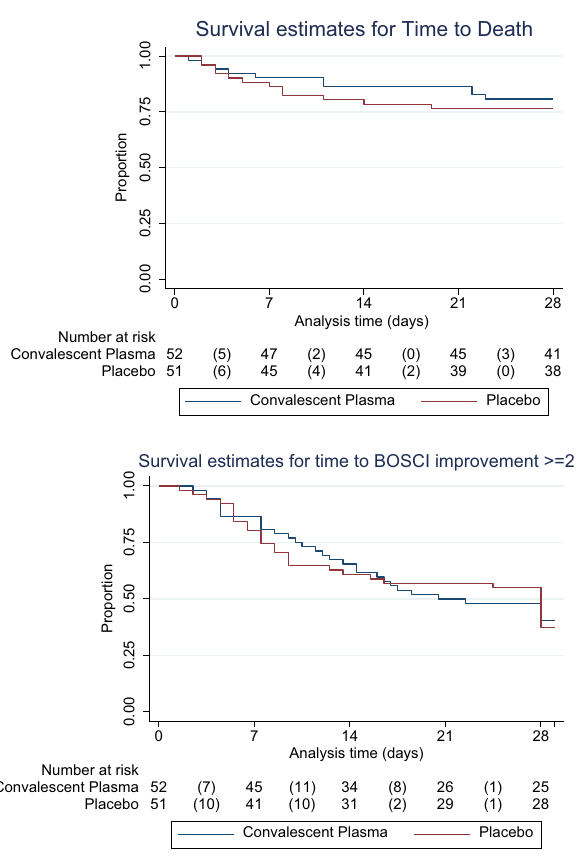
Figure 3. Kaplan–Meier survival analysis of time to death and separately for improvement by ≥ 2 BOSCI points in 103 participants with moderate-severe COVID-19 randomized treatment with convalescent plasma versus placebo. *BOSCI: World Health Organization Blueprint Ordinal Scale for Clinical Improvement.